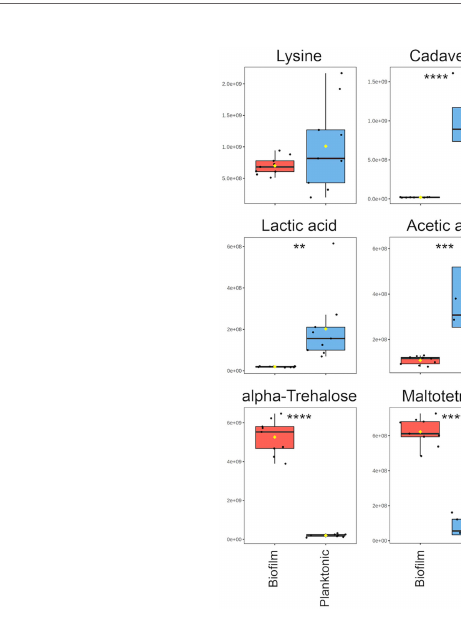
FIGURE 3 | Notable metabolite differences between planktonic and bio fi lm include intermediates of the cadaverine branch of the lysine degradation pathway (LDP), weak organic acids, and carbohydrate-related metabolites. Box plots represent a metabolite fold change analysis between bio fi lm (red) and planktonic (blue) cohorts (n=9). The black circles represent independent sample values, boxes represent upper and lower quartiles, black bars represent median, yellow diamonds ( ♦ ) represent mean value, whiskers represent minimum and maximum values, and asterisks denote signi fi cance (* p < 0.05, ** p < 0.01, *** p < 0.001, **** p < 0.0001 by unpaired, two-tailed t